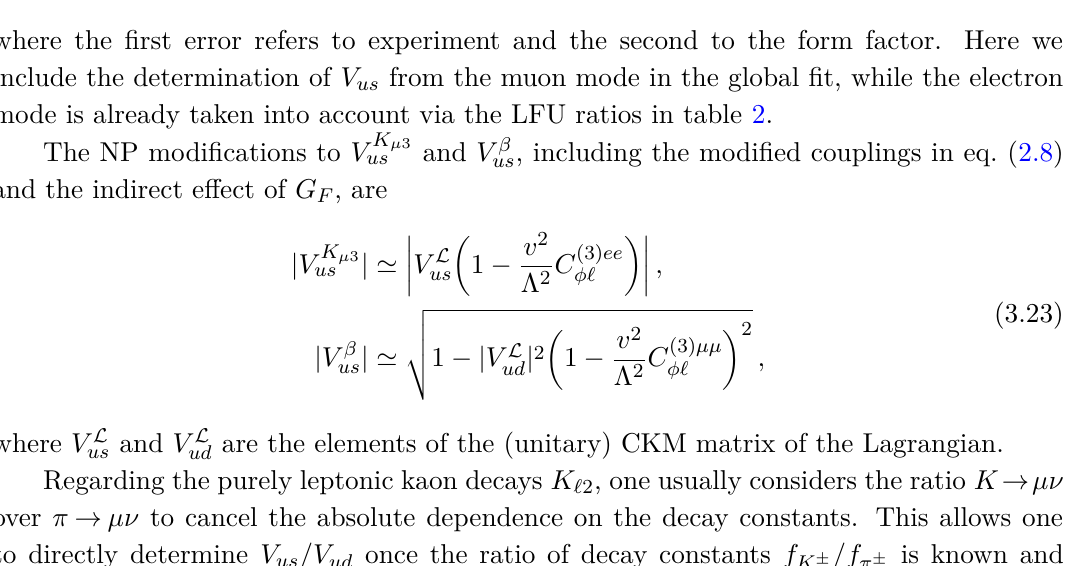
Figure 2 . Global Fit in the LFU scenario with C (3) to the standard fit (not including CKM elements), while the red regions include V us and V ud by assuming CKM unitarity. The blue dashed lines indice the region obtained if the additional NNCs are